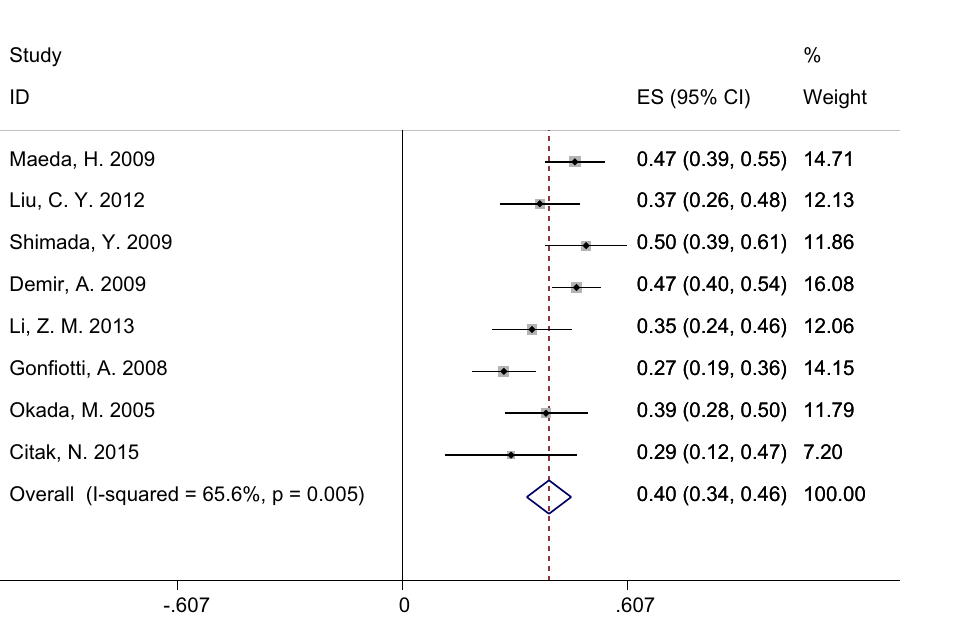
Figure 3. Forest plot of 5-years OS for patients diagnosed with pN1h